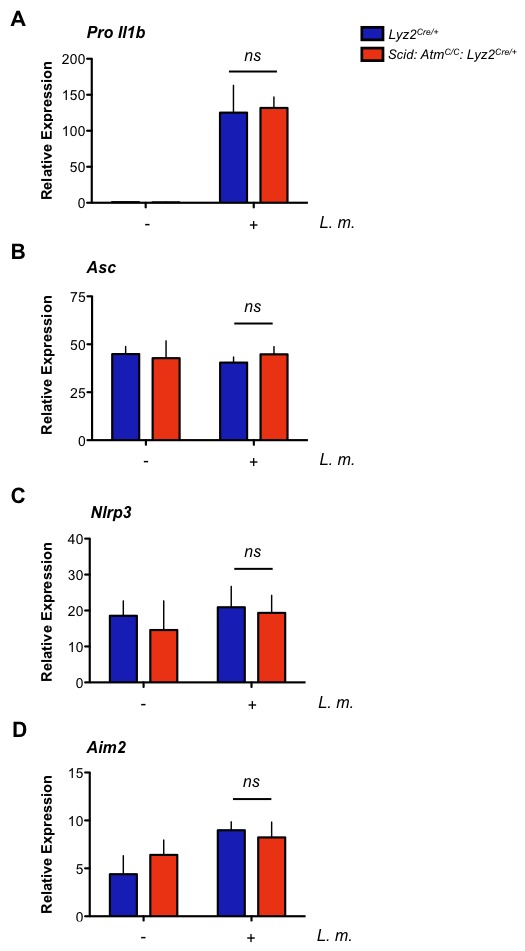
Gene expression of inflammasome components.(A–D) Quantitative RT- PCR analysis of (A) pro Il-1β, (B) Asc, (C) Nlrp3, and (D) Aim2 gene expression in Scid: AtmC/C: Lyz2cre/+and Lyz2cre/+BMDMs infected (+) or not (-) with L. m. Data are a compilation of three independent experiments and depict mean and SEM. ns = not significant.